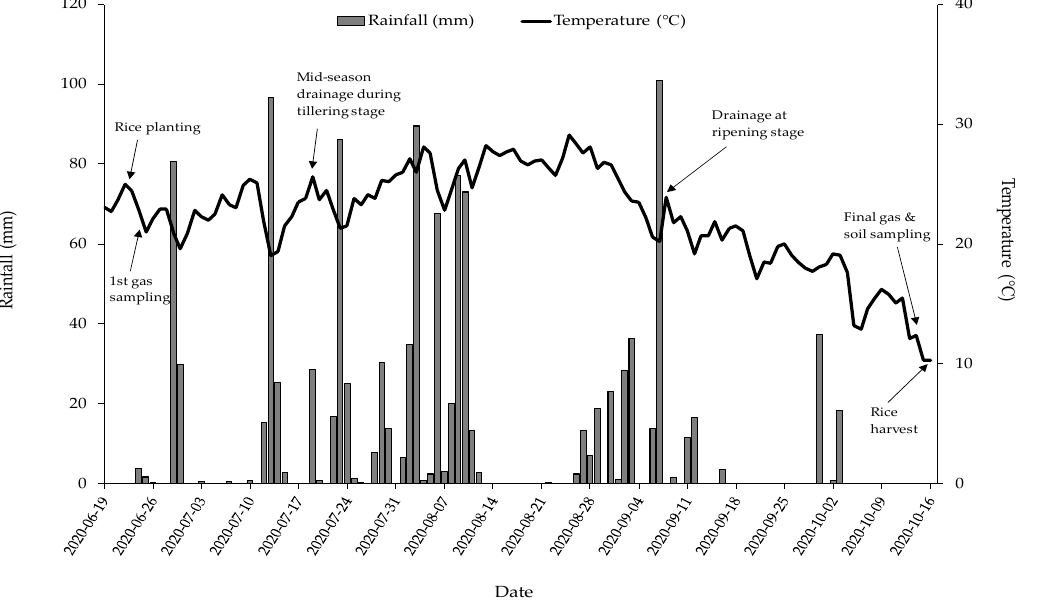
Figure 1. Precipitation and average temperature in the experimental paddy fields measured by the Hongseong weather station of Korea Meteorological Administration.